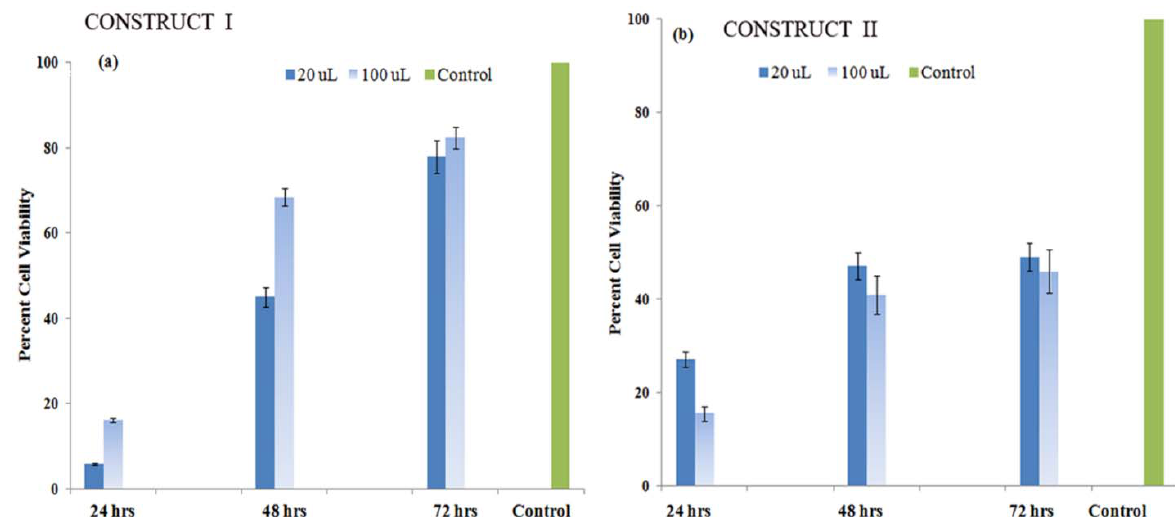
Figure 8. MTT cell viability assay comparing bovine chondrocyte cell proliferation in the presence of ( a ) Construct I and ( b ) Construct